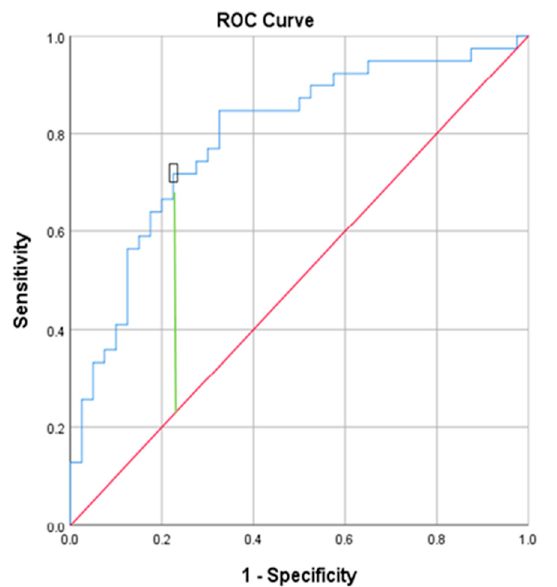
Figure 1. ROC curve sensitivity represents true-positive results and 1—specificity, the false positive results. The best TyG index value indicating insulin resistance was 4.695, Youden Index = 0.49.